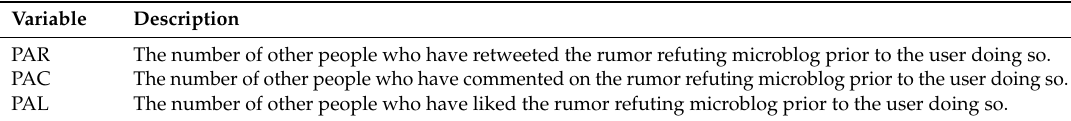
Table 7. The three introduced group behavior